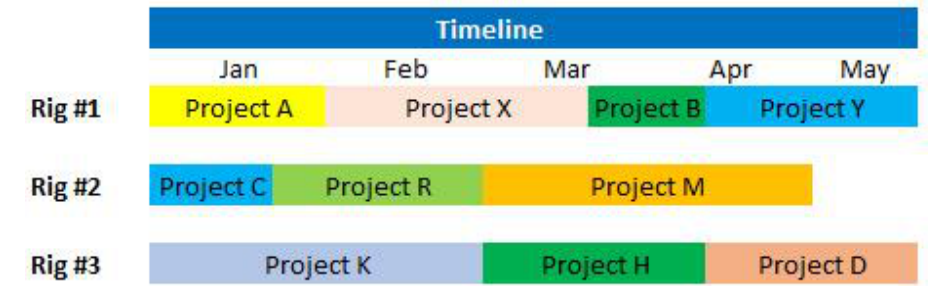
Figure 2—An illustration of drilling project timeline and number of rig allocation schedule.